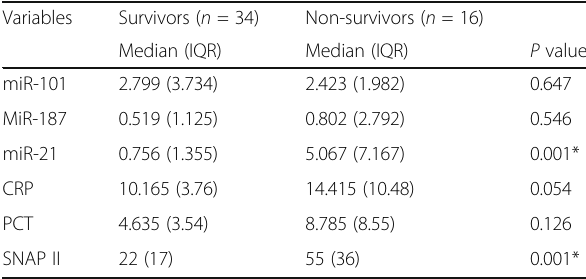
Table 3 Comparison of miRNAs 101, 187, and 21 expression levels (2 −Δ Ct ) and the clinical indicators between sepsis survivors and non-survivors